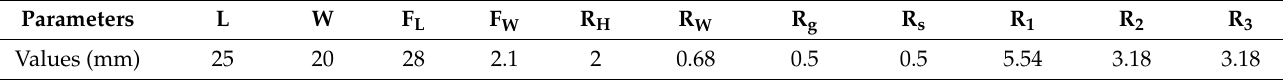
Table 1. Triple-rings design parameters.